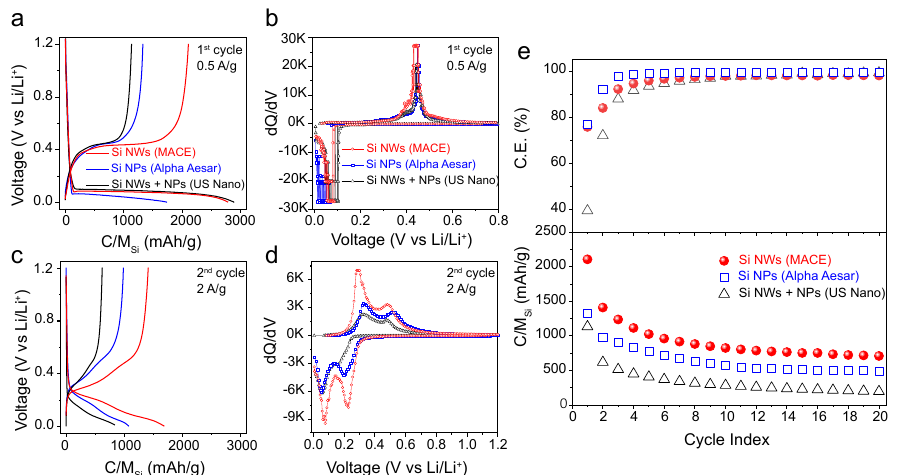
Figure 4. Electrochemical performance of selected material, as labelled (MACE-SiNWs, SiNPs- AlphaAesar, SiNWs/SiNPs-US). ( a , c ) are galvanostatic charge-discharge (GCD) curves of the three selected materials during the 1st ( ≈ 1/8 C) and 2nd cycles ( ≈ 1/2 C) of the galvanostatic cycling, respectively. ( b , d ) are the dQ/dV profiles obtained from the GCD curves corresponding to each electrodes. Figure ( e ) shows the coulombic efficiency and specific capacity of the selected